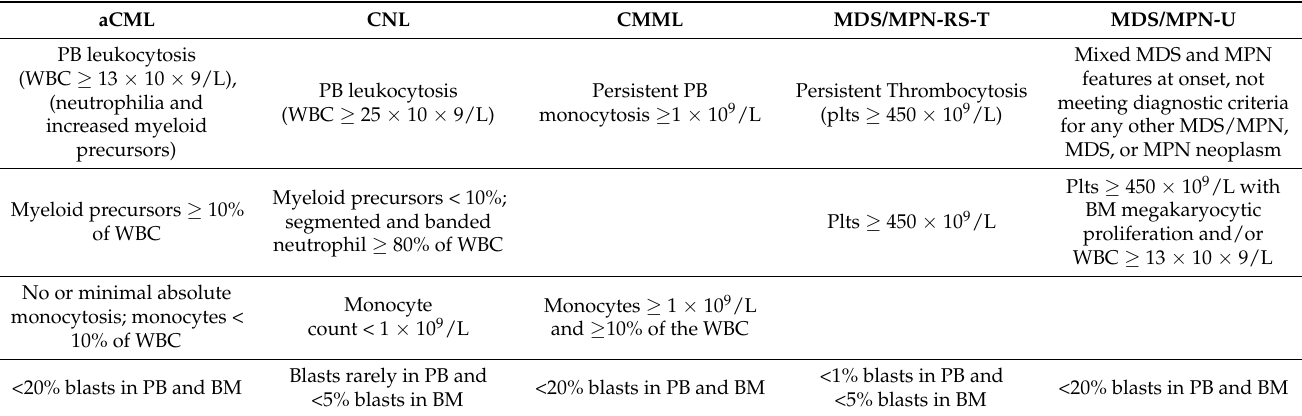
Table 1. Differential Diagnosis in Atypical Chronic Myeloid Leukemia (aCML). CNL: Chronic Neutrophilic Leukemia; CMML: chronic myelomonocytic leukemia; MDS/MPN-RS-T: MDS/MPN neoplasm with ring sideroblasts and throm- bocytosis; MDS/MPN-U: MDS/MPN neoplasm unclassifiable; PB: peripheral blood; WBC: White Blood Cell count; Plts: platelets; MDS: myelodysplastic syndrome; MPN: myeloprolipherative neoplasm; BM: bone marrow; CML: Chronic